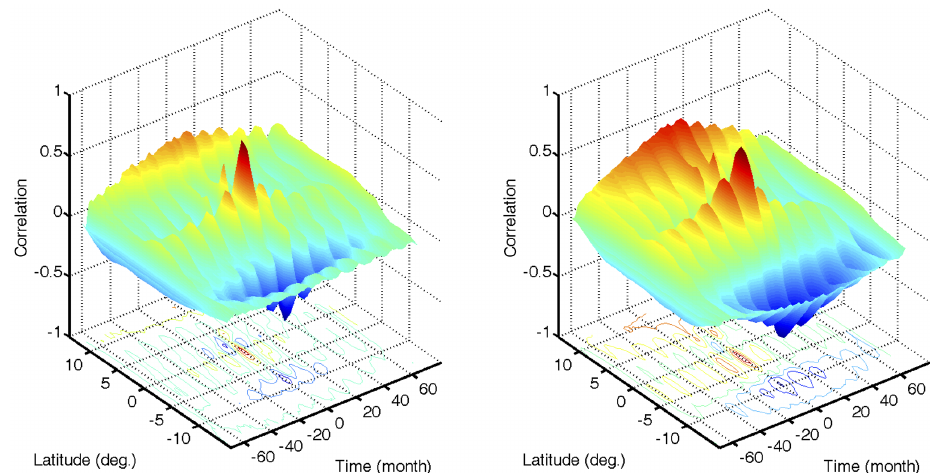
Figure 6. Correlation matrixes between the Hovmöller diagrams of the surface wind divergence (SWD, with a negative sign) and the cloud optical thickness (COT, left) and the cloud fraction (CF, right). Both matrixes show that the correlation peaks correspond to no shift in time ( x axis). The peak correlation with COT, R = 0 . 74, also corresponds to no shift in latitude ( y axis). The peak correlation with CF, R = 0 . 75, corresponds to a 2 ◦ southward shift relative to the SWD field, suggesting a stronger link to the cold SST over the Equator than to meridional gradient of SST (gradSST).